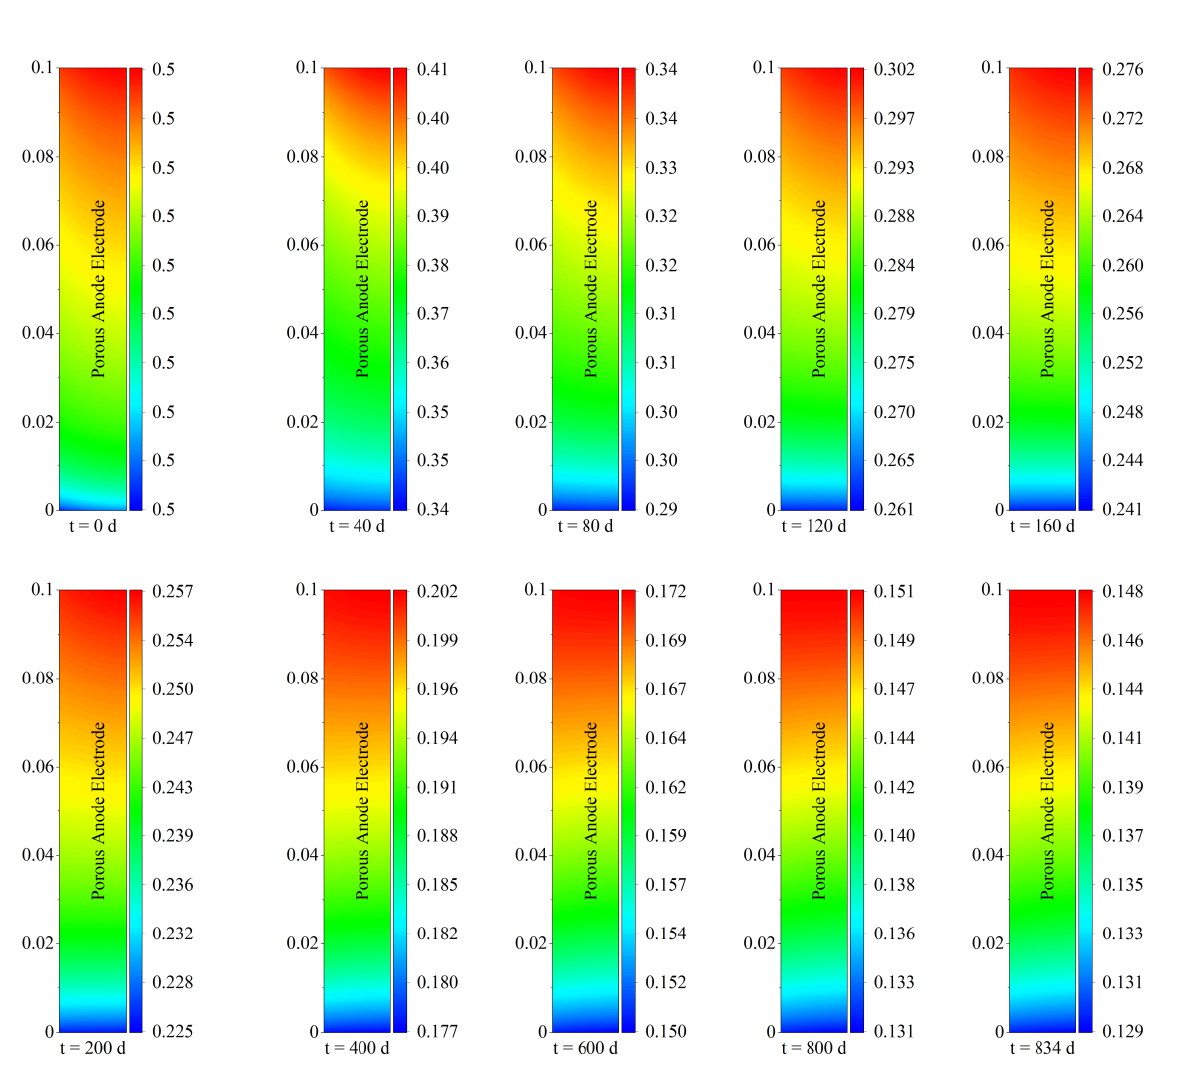
Figure 5. The spatial and temporal evolution of porosity within the porous anode electrode of the solid oxide fuel cell during 20,000 h of steady − state operation.